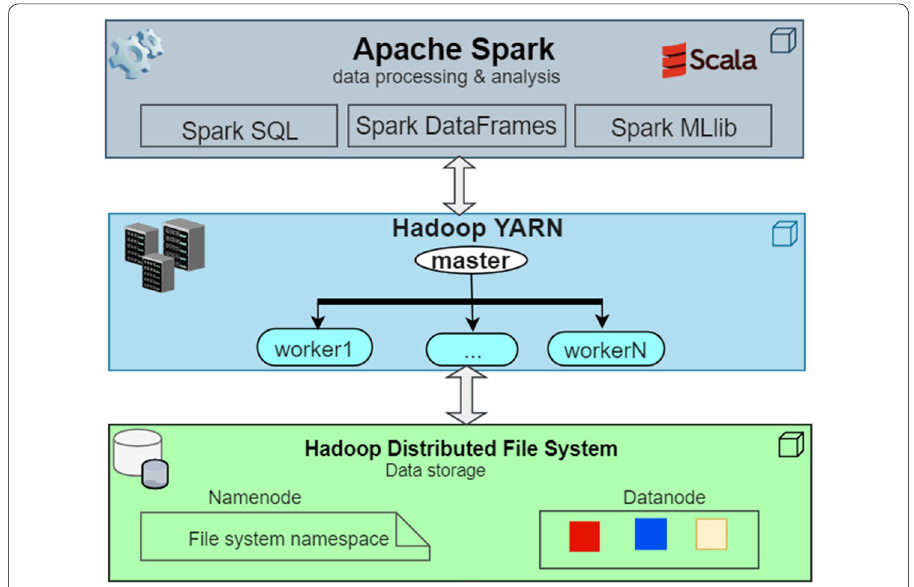
Fig. 3 Big data technologies: This approach uses a combination of several big data Framework that communicates with each other for running the course recommender system in a distributed